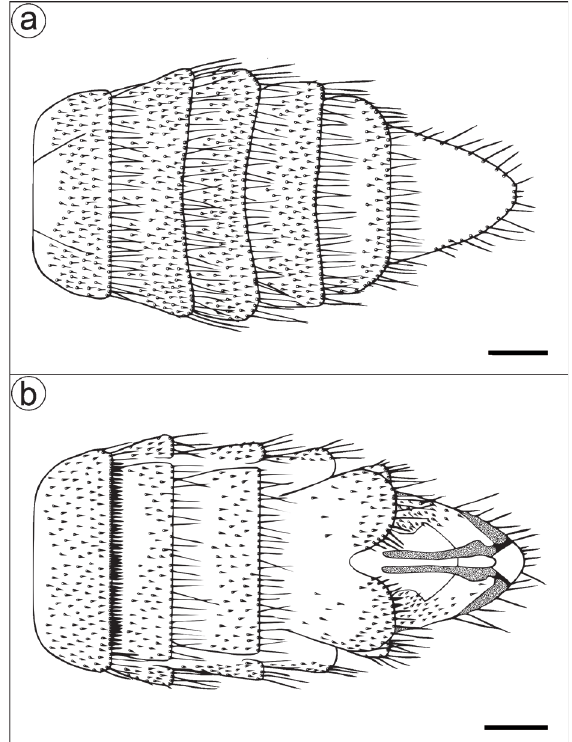
Figure 4. a) Abdomen, male (Paratype), dorsal view, Hershkovitzia mariae sp. nov. (Scale bar = 0.2 mm approx.). b) Abdomen, male (Paratype), ventral view, Hershkovitzia mariae sp. nov. (Scale bar = 0.2 mm